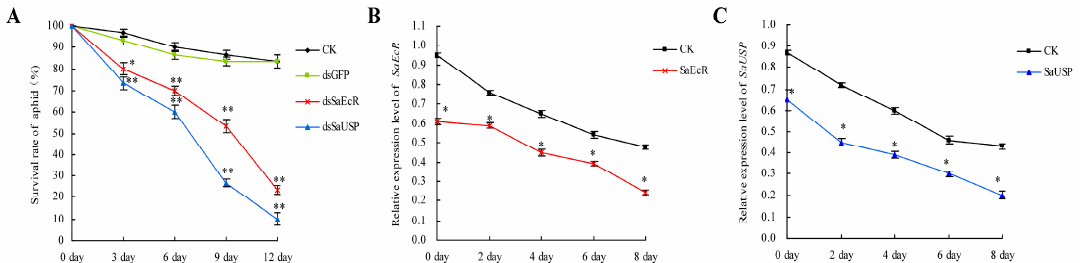
Figure 4. Persistent silencing effects of RNAi in grain aphid. ( A ) Effects of SaEcR and SaUSP silencing on the survival rate of grain aphid after transferring onto wheat plants. The survival rate of aphids after dsRNA feeding continued to decrease significantly even after transferring to wheat plants (Student’s t -test, n = 3, * p < 0.05, ** p < 0.01). Bars represent mean values ± SEM of three independent biological replicates, each with a pool of 30 individual aphids; ( B ) Expression profile of SaEcR after transferring to wheat plants (Student’s t -test, n = 3, * p < 0.05). Bars represent mean values ± SEM three independent biological replicates, each with a pool of eight surviving individual aphids; ( C ) Expression profile of SaUSP after transferring to wheat plants (Student’s t -test, n = 3, * p < 0.05) . Bars represent mean values ± SEM of three independent biological replicates, each with a pool of eight surviving individual aphids.